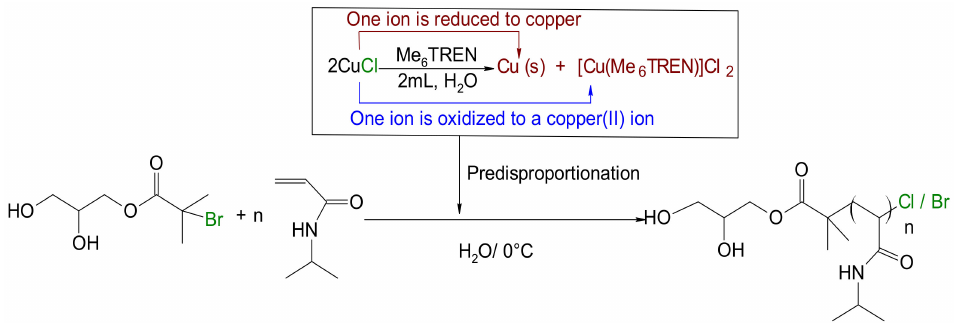
Scheme 5. Synthesis of PNIPAM by Cu(0)-mediated polymerization in H 2 O at 0.0 ◦ C via prior dis- proportionation of [Cu(Me 6 TREN)Cl]. Conditions: [bromo-initiator]:[CuCl]:[Me 6 TREN] =